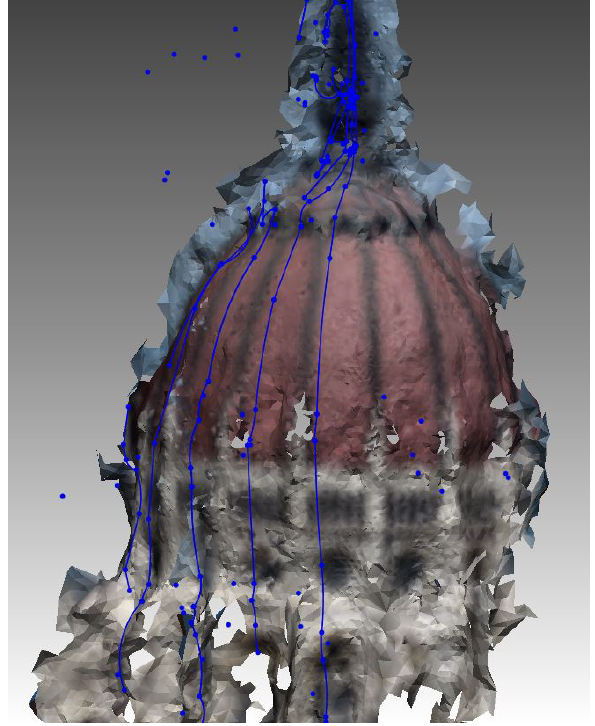
Figure 5. Mesh model of the Parliament’s cupola with some sec- tion lines